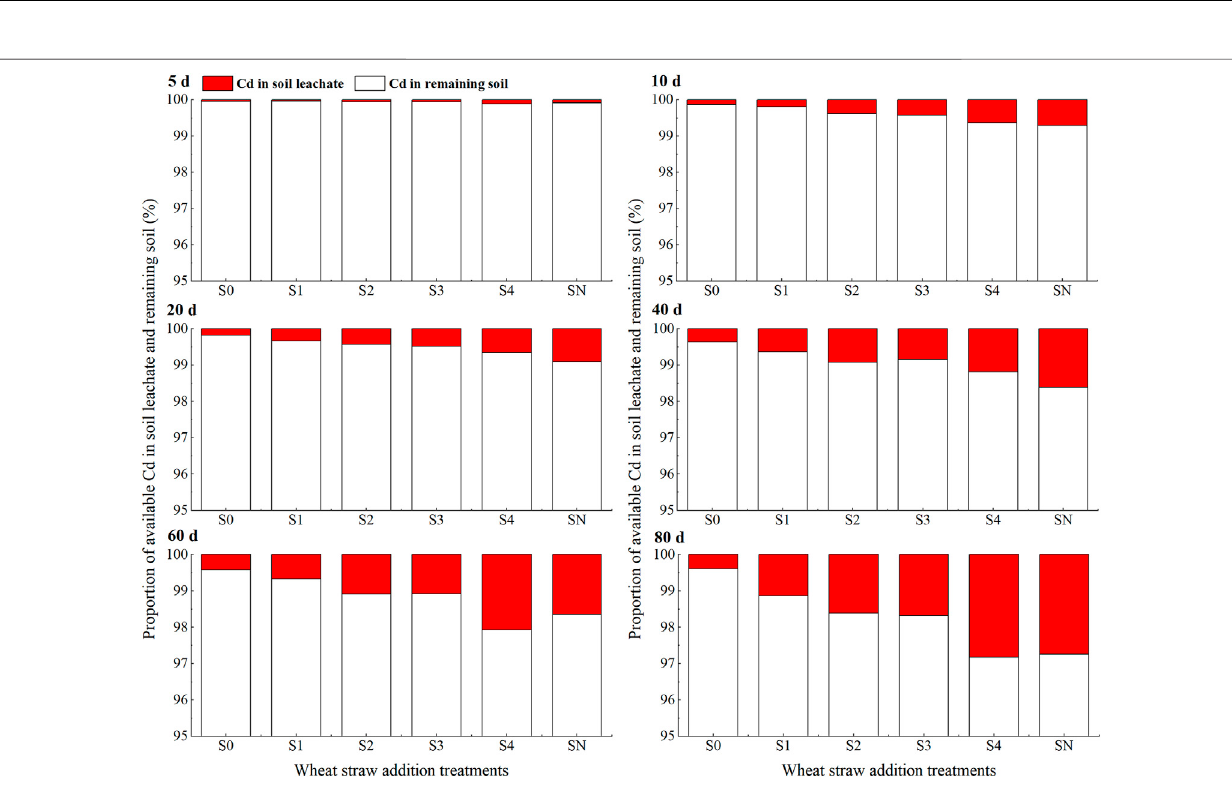
Frontiers in Environmental Science |